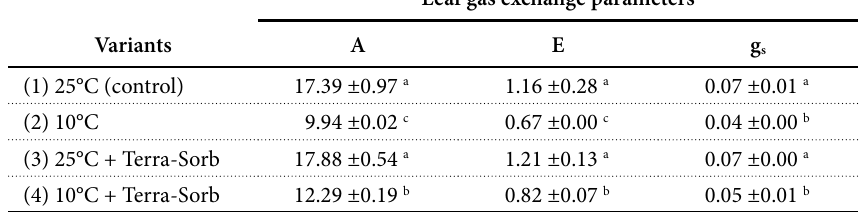
Tab. 3 Influence of chilling and the biostimulant Terra-Sorb Foliar on photosynthetic pigment content (mg g −1 fresh weight) and ratio in young maize plants.